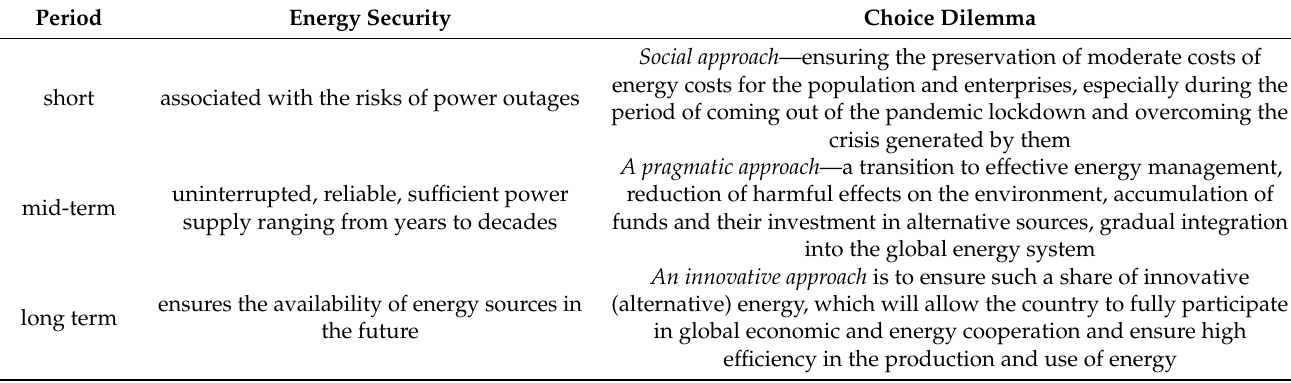
Table 3. Methodological approaches to solving the